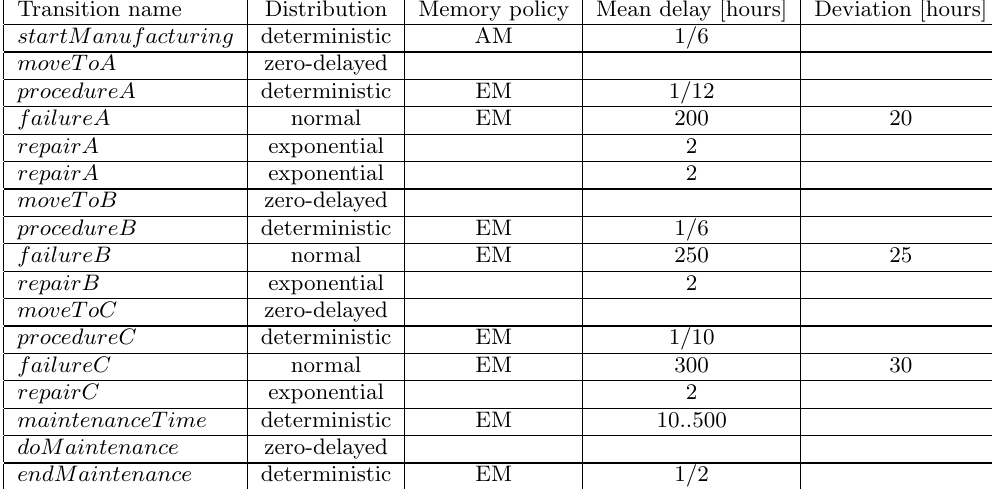
Transition name